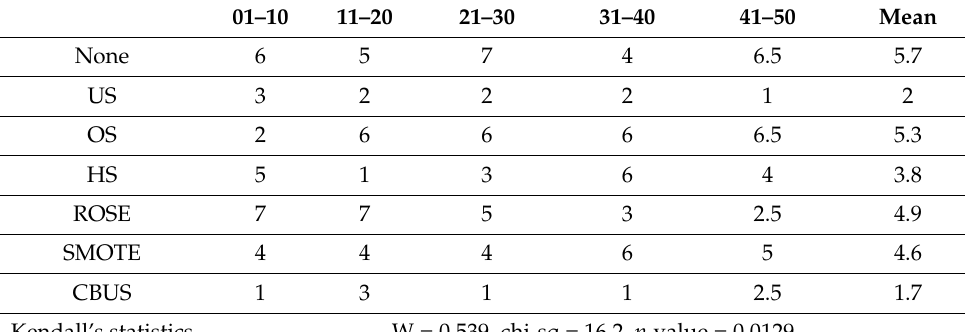
Table 19. Ranks of DBT for RF for varying levels of IR.